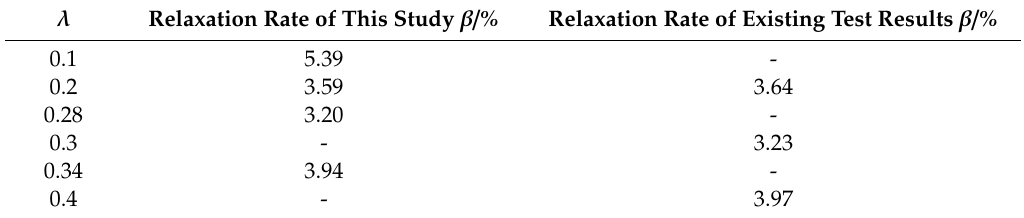
Table 7. The relaxation rate of carbon fiber cloth with di ff erent prestressing